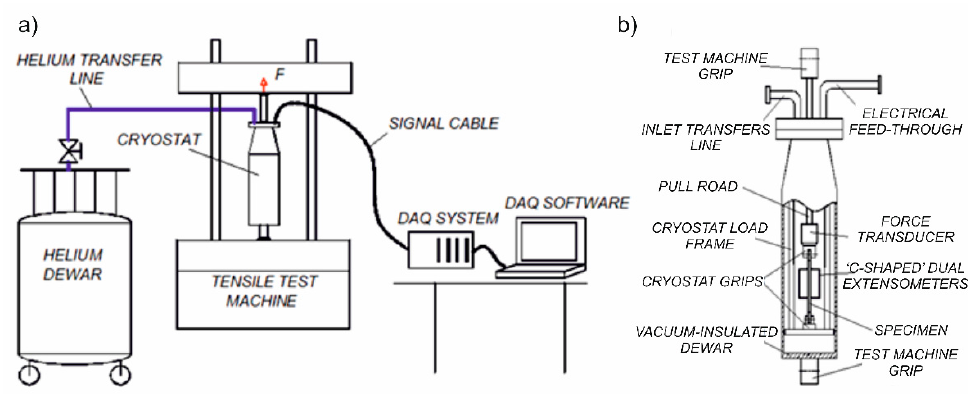
Figure 1. ( a ) Experimental set-up for a uniaxial tensile test at cryogenic temperatures; ( b ) cryostat with the specimen and transducers.